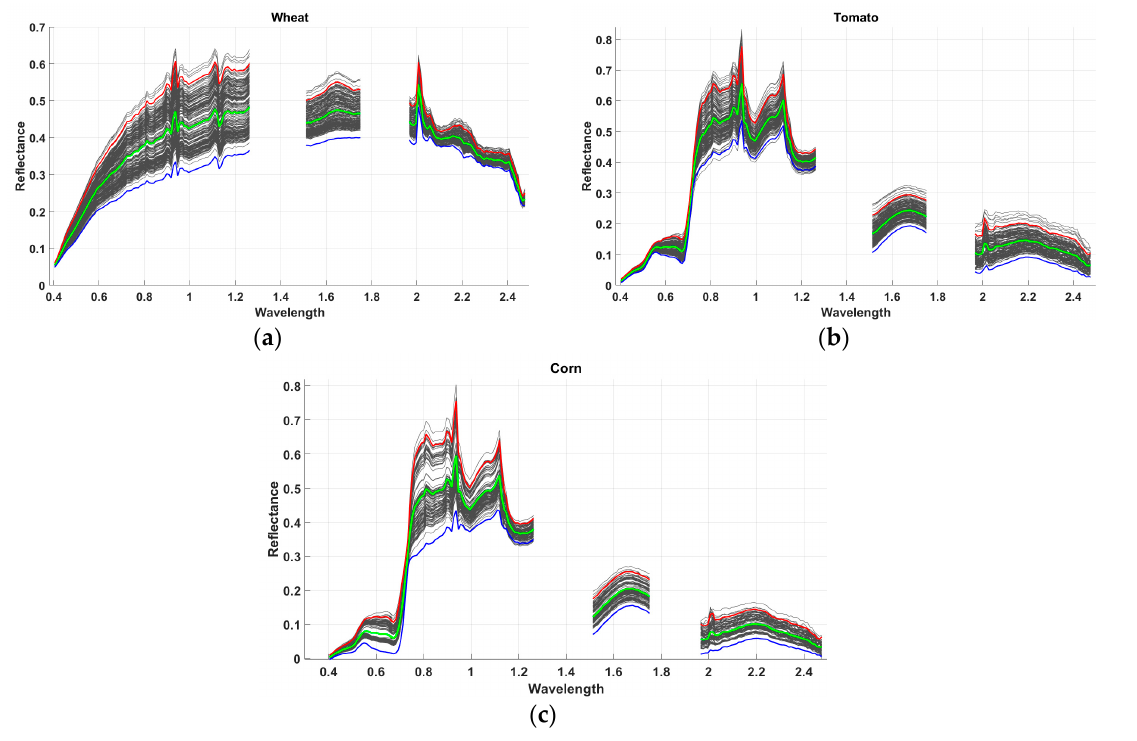
Figure 8. The spectral variability of pixels for three classes of: ( a ) Wheat; ( b ) Tomato; and ( c ) Corn.